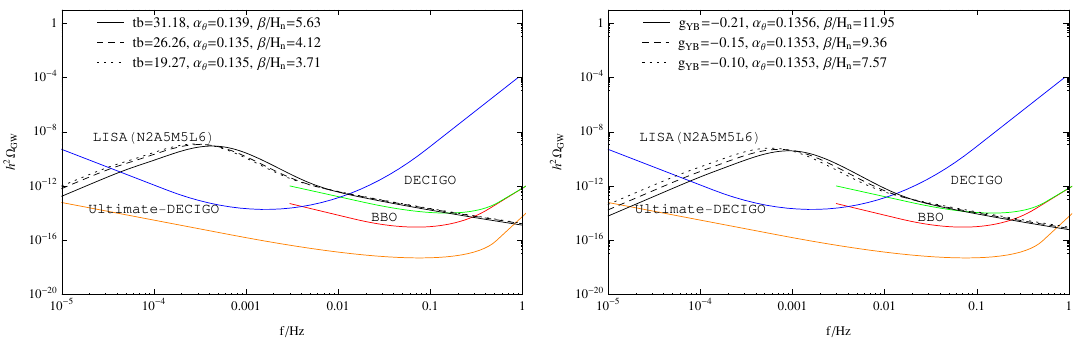
3.71tb = 26.26, Α Θ = 0.135, Β (cid:144) H n = 4.12 tb = 19.27, Α Θ = 0.135, Β (cid:144) H n =